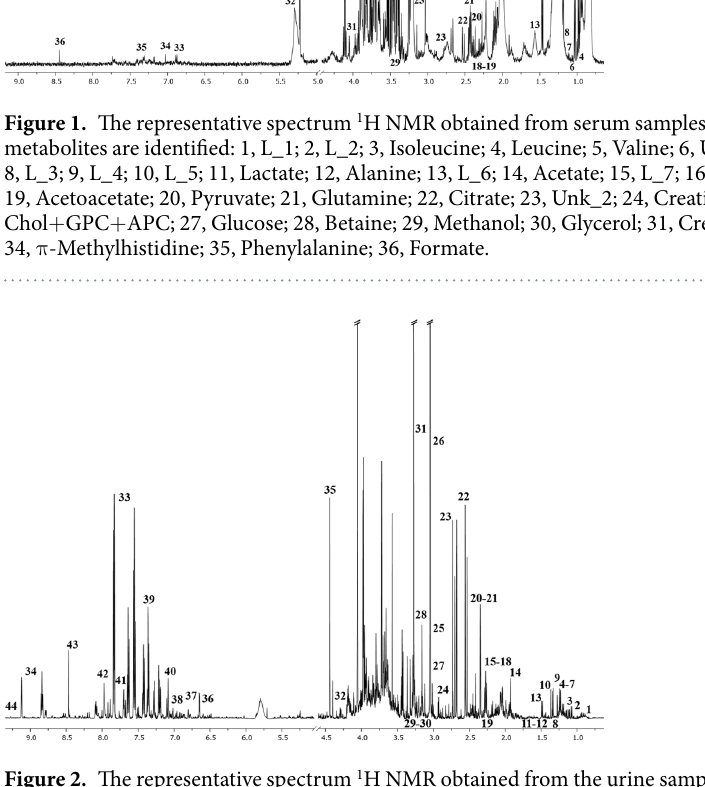
In the case of models obtained on the fusion data, the basic model parameters were significantly better (Table 2). In support of this finding, the results also showed differences in ROC curve (Fig. 5) and AUC training (Table 2) values for all of the comparisons, which indicates a better fit for the model that uses the selected samples in relation to the models, that were constructed separately on serum or urine. As in the case of the obtained mod- els for each biofluid model based on data fusion, the best performance was observed in the case of the comparison of HC vs NN /FA/TC and the total number of patients (P) with pathological changes (Table 2). For all of the models, all of the values that were obtained were above 0.83 (FA vs TC), while the highest value was 0.99 for TC vs HC comparison. The possibility of formulating prediction models was also higher in terms of comparisons of HC to pathological changes of the thyroid (Table 2). The highest predictive value was characterized by FA vs HC, which reached the AUC test of 1.00, while the lowest value was obtained for NN vs HC with an AUC test of 0.82. The data fusion from the serum and urine NMR measurements definitely strengthened of calculated models between the NN, FA, TC, P and the HC groups. That finding was due to the increased number of variables, which theoretically could add complementary information to the obtained models. The AUC values were between 0.82